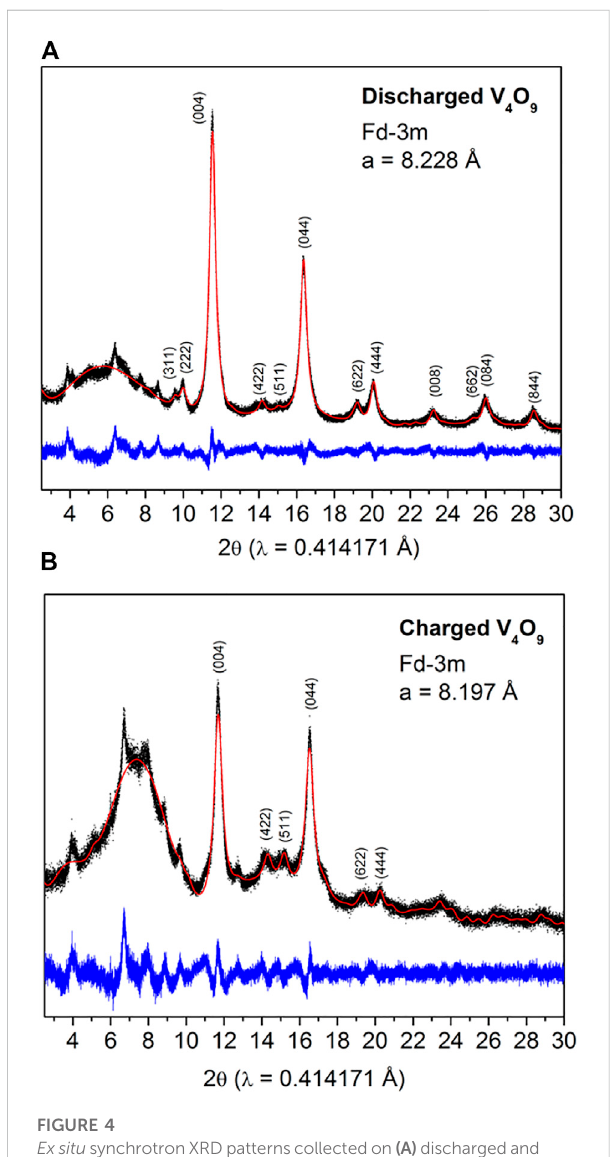
FIGURE 4 Exsitu synchrotronXRDpatternscollectedon (A) dischargedand (B) charged V 4 O 9 electrode samples. The red dots and black and blue solid lines correspond to observed and calculated patterns and their difference, respectively. The broad bump at 7 ° 2-theta is due to the Kapton tape that is protecting the sample from ambient